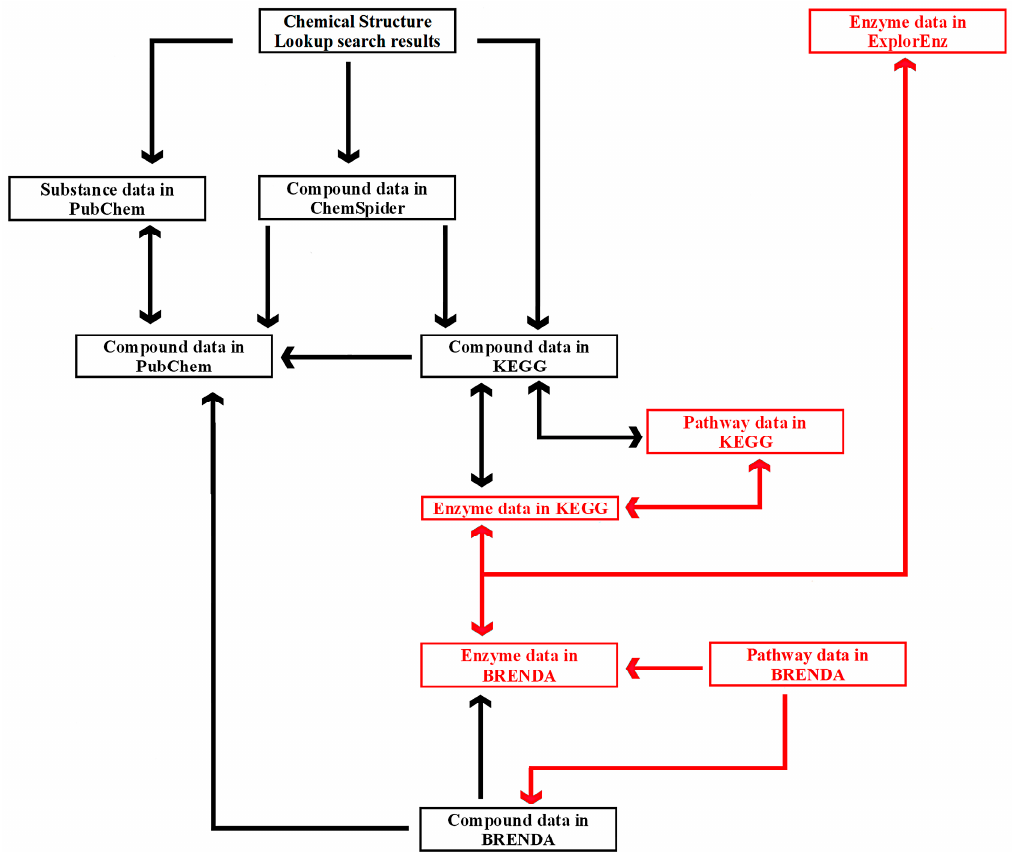
Figure 5. Diagram of links optionally redirecting the user to information about specific compounds, enzymes, and metabolic pathways in the discussed databases. Compound data and the relevant links are marked in black, and enzyme and pathway data with links are in red. Arrows indicate possible directions of search.